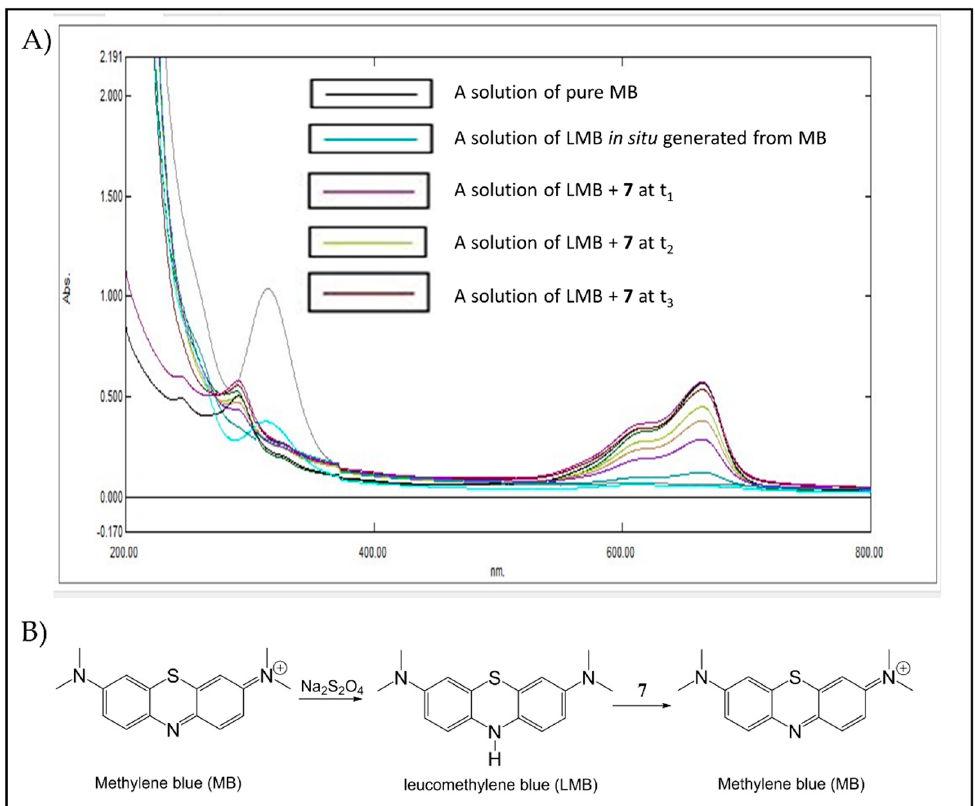
Figure 8. ( A ) UV-Vis analysis of oxidation of leucomethylene blue (LMB) by trioxane 7 . MB (6.6 x 10 − 4 mmol) was completely converted to LMB (disappearance of the absorption band at 650 nm, azure line) by the treatment with sodium dithionite (1.4 × 10 − 4 mmol) under argon at 37 °C. Trioxane 7 (4 × 10 − 4 mmol) in MeCN was added, and the absorption of the mixture at 650 nm was monitored at an interval (t 1 –t 3 ) of 20 s until complete oxidation of LMB back to MB (within 10 min). ( B ) Proposed mechanism of the in situ generation of LMB from MB and the oxidation of LMB by 7 to regenerate LB.